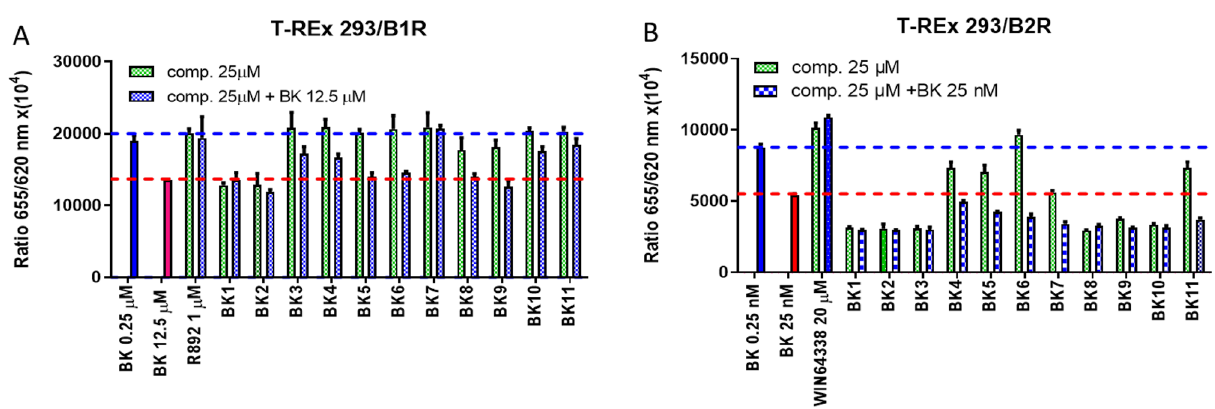
Figure 2. The activity of BK derivatives in the screening assay: ( A ) B1R and ( B ) B2R. The blue dashed line represents the lowest BK concentration that does not work, and the red line corresponds to the EC 80 value for a given receptor. Agonistic effects were examined by treating cells with the compounds alone (green bars) or with BK in EC 80 to examine their inhibitory effects (red